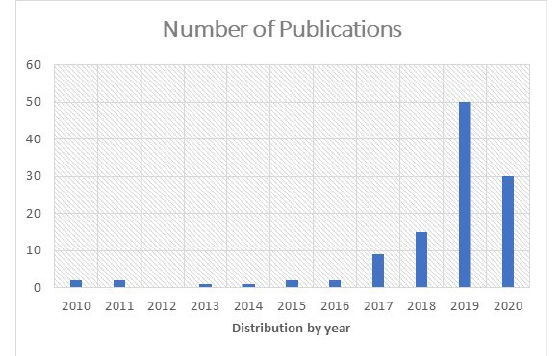
Figure 5. Type of publications in